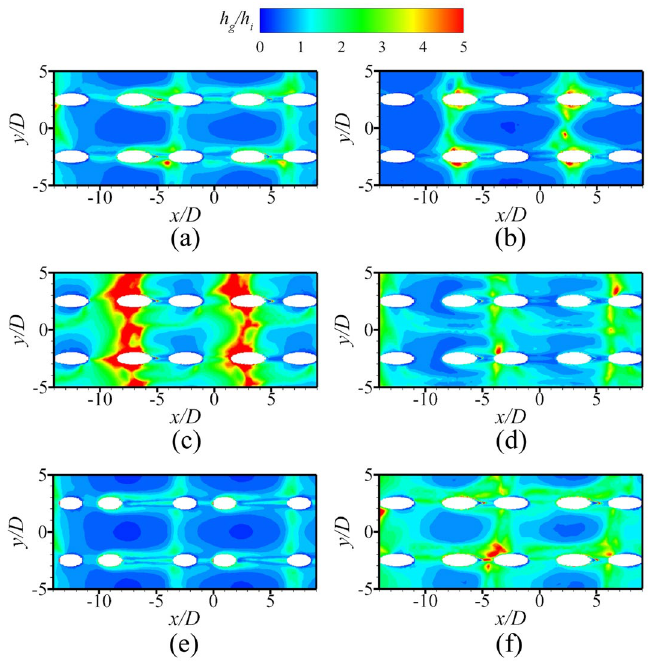
Figure 20. Contours of h g / h i for impingement-effusion model (first two rows: different impingement hole distributions; last row: different impingement hole diameter D imp ). ( a ) Ref-case #2; ( b ) Span parallel; ( c ) Overlapped; ( d ) Streamwise parallel; ( e ) D imp = 1.5 D ; (f) D imp = 2.5 D .